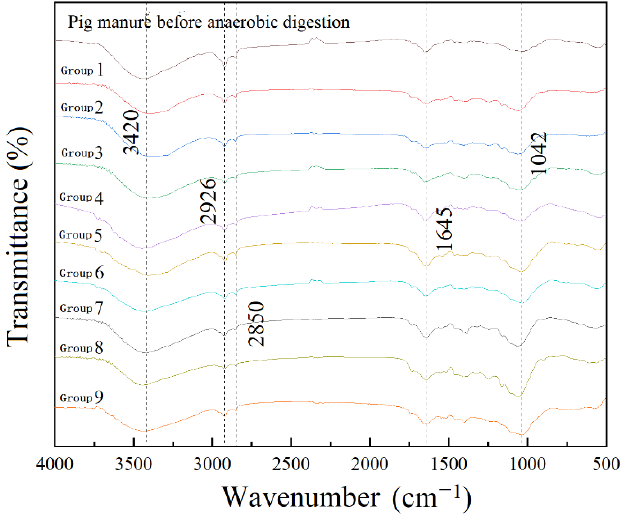
Figure 6. FTIR spectra of pig manure before and after anaerobic digestion with different compound passivators.